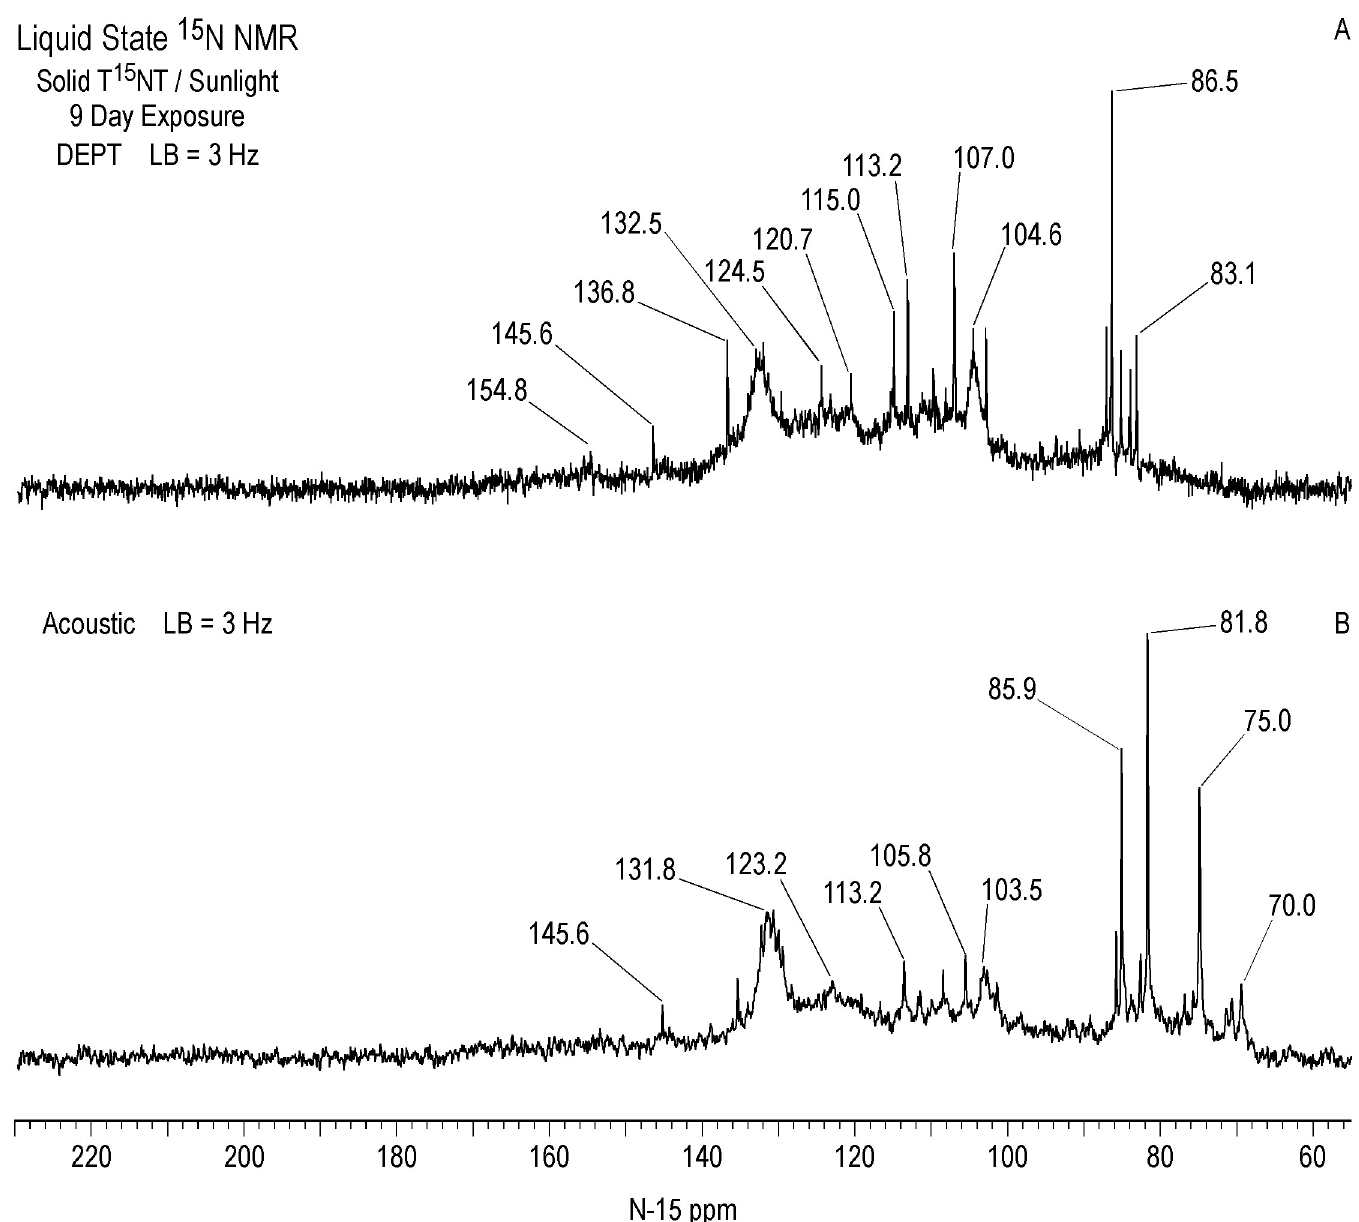
Fig 23. Liquid state N-15 NMR spectra of solid T 15 NT subjected to sunlight irradiation. A. DEPT spectrum showing all nitrogens bonded to protons. B ACOUSTIC spectrum phased 180˚. LB = line broadening.